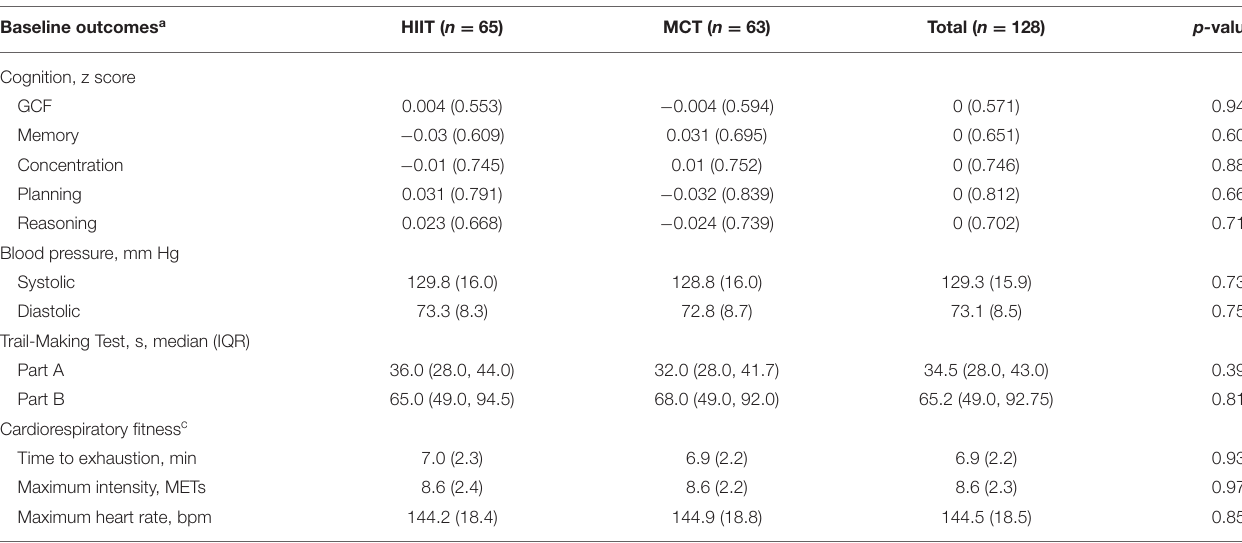
TABLE 2 | Study baseline